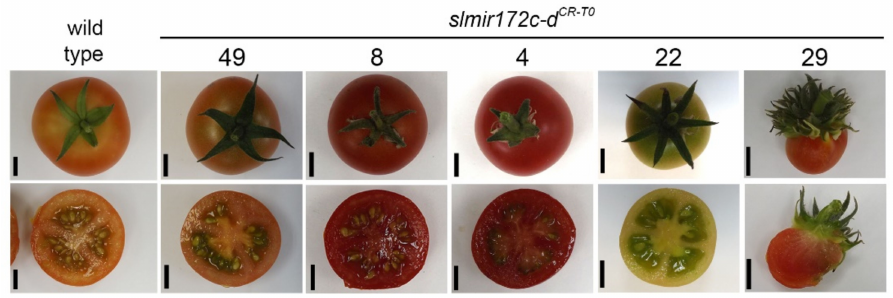
Figure 4. Fruit phenotypes of slmiR172c-d CR-T0 plants. Representative pictures of indicated wild type and mutant whole fruits and their manual cross-sections. Scale bars = 1